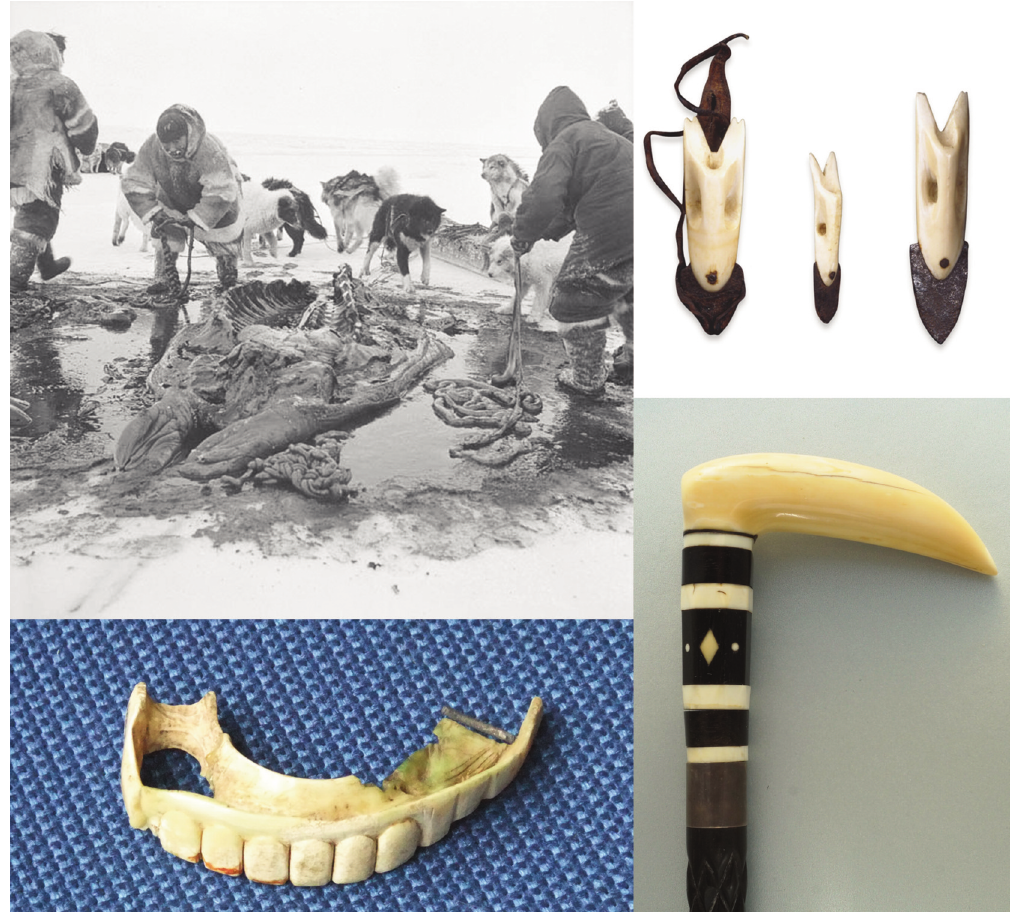
Fig. 8. Walruses have provided materials for many purposes (proceeding clockwise from upper left): upper left) first and foremost they have been and remain an important source of food for Inuit and their dogs (Source: © Library and Archives Canada/ PA-168606, credit: R. Harrington /Richard Harrington fonds); upper right) their strong, durable ivory was vital for making tools such as harpoon heads even after the arrival of metals (collected in 1738 from Hudson Strait; photo © Trustees of the British Museum); lower right) more recently Europeans have incorporated walrus ivory into trade items such as this walking stick (ca. 1850–1900) (credit: D.B. Stewart); and lower left) for the fabrication of dentures (source: Whitby